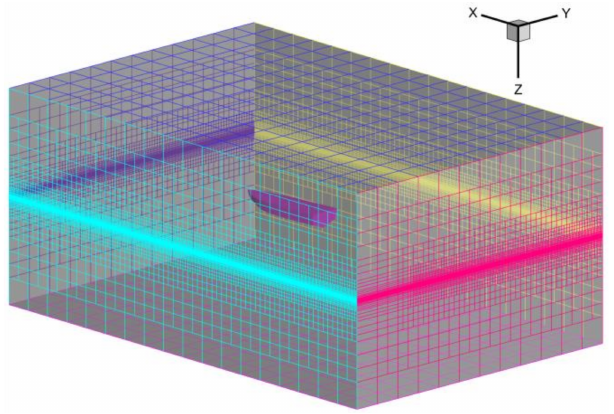
Figure 3. Compute grid.